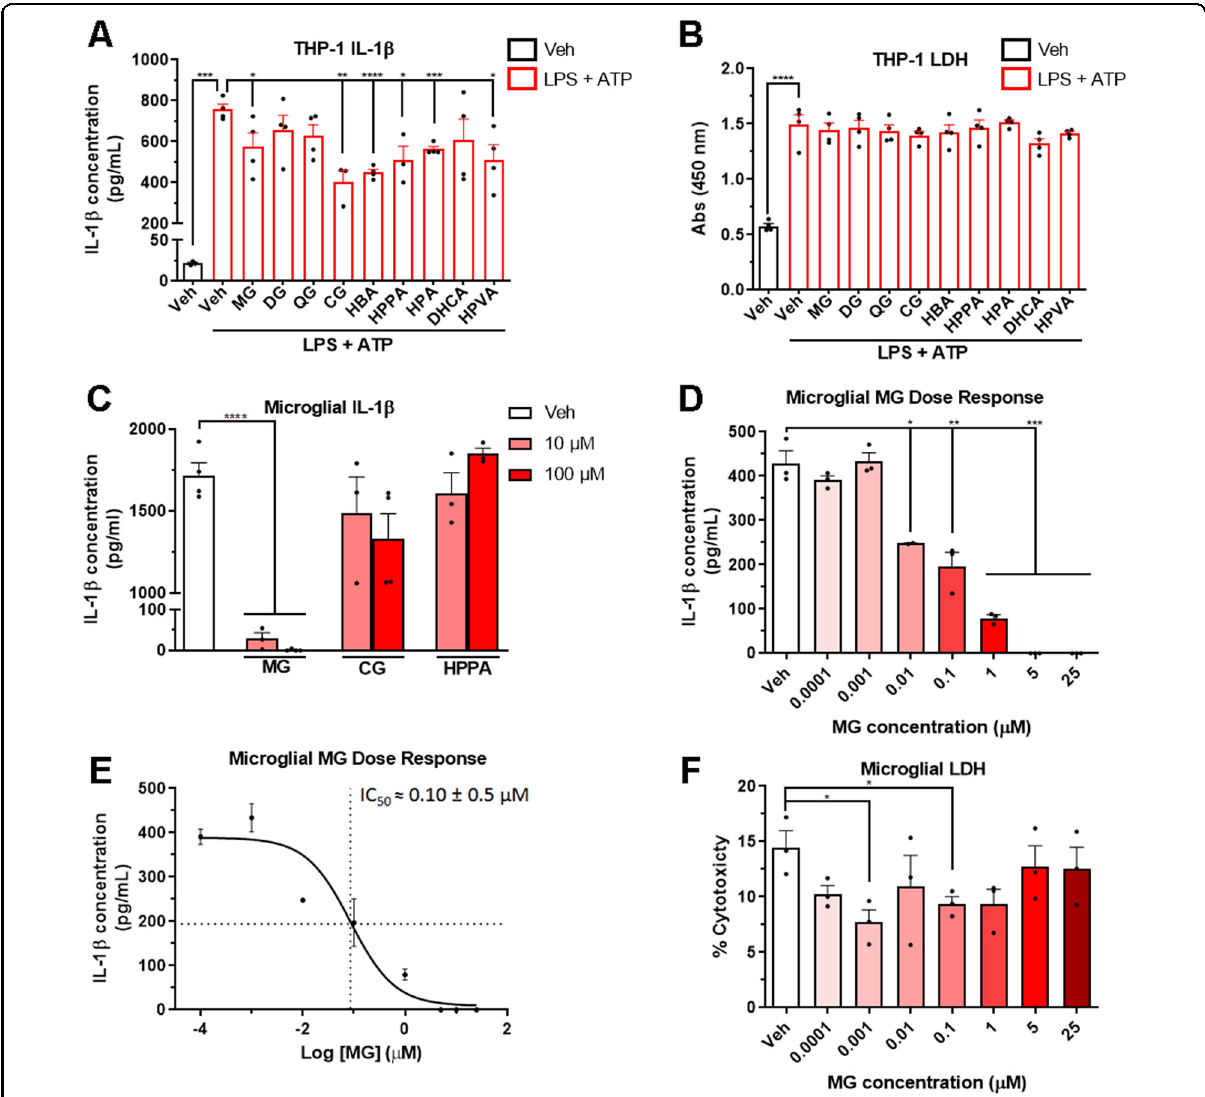
Fig. 2 Select phenolic metabolites derived from FDP inhibit NLRP3-dependent production of IL-1 β . ( A ) Secretion of IL-1 β from THP-1 macrophages pre-treated with phenolic metabolites and then stimulated with LPS and ATP. MG: malvidin-glucoside. DG: delphinidin-glucoside. QG: quercetin-glucuronide. CG: Cyanidin-glucoside. HBA: 3-hydroxybenzoic acid. HPPA: 3-(3 ′ -hydroxyphenyl)propionic acid. HPA: 3-hydroxyphenylacetic acid. DHCA: 3-(3 ′ , 4 ′ -dihydroxyphenyl)propionic acid. HPVA: 5-(4 ’ -hydroxyphenyl)valeric acid. ( B ) Release of LDH from THP-1 macrophages pre-treated with phenolic metabolites then stimulated with LPS and ATP. ( C ) Secretion of IL-1 β from mouse primary microglia pre-treated with phenolic metabolites and then stimulated with LPS and ATP. ( D ) Secretion of IL-1 β in mouse primary microglia pre-treated with increasing concentrations of MG and stimulated with LPS and ATP. ( E ) Calculation of IC 50 of IL-1 β secretion in response to MG pretreatment and LPS and ATP stimulation. ( F ) Cytotoxicity of microglial cultures in response to MG pre-treatment, measured by LDH release. N = 3 – 4 biological replicates/group, performed in duplicate. * p < 0.05 , ** p < 0.01 , ***p < 0.001, ****p < 0.0001 by Student ’ s t-